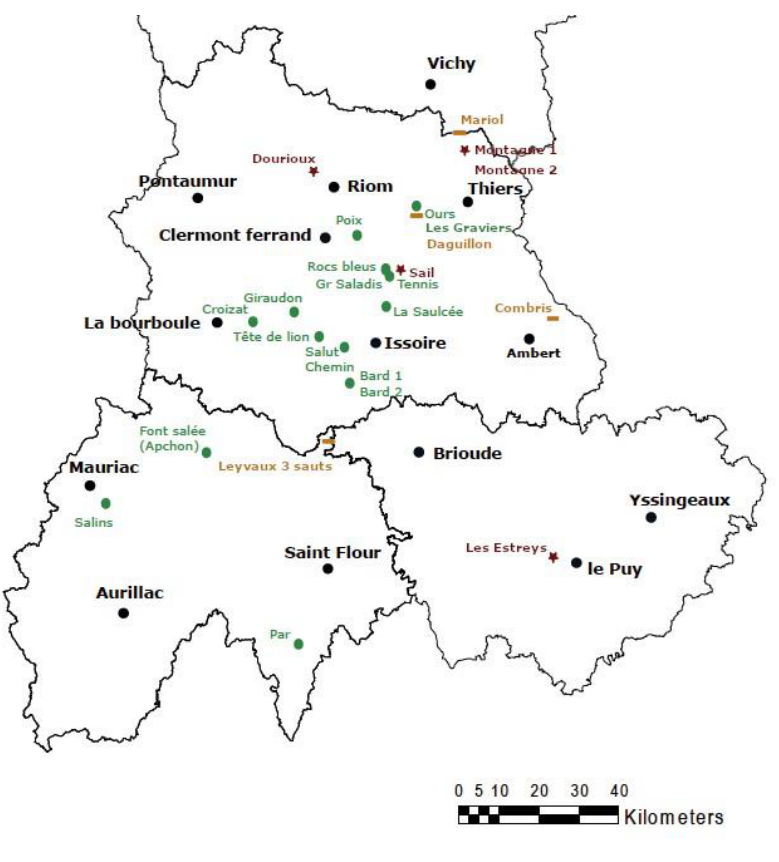
Fig. 1 . Map of the sampled mineral springs in Auvergne illustrated according to the radon activity levels in water: green circle – low activity, orange line – medium activity, red star – high